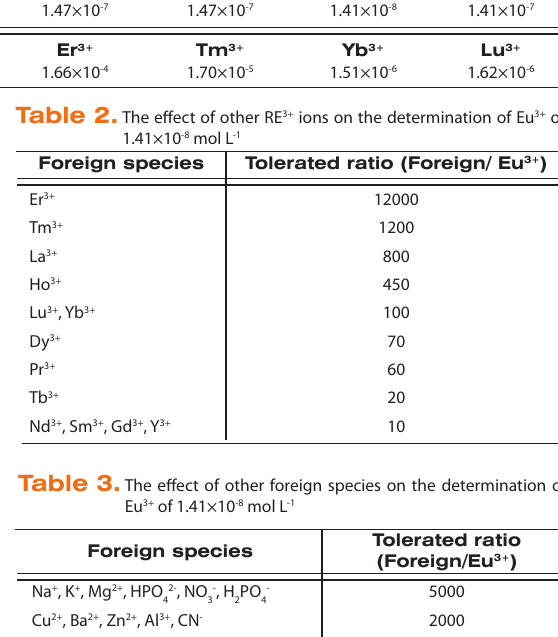
Figure 3. Calibration curve for the ∆T versus -logC Eu3+